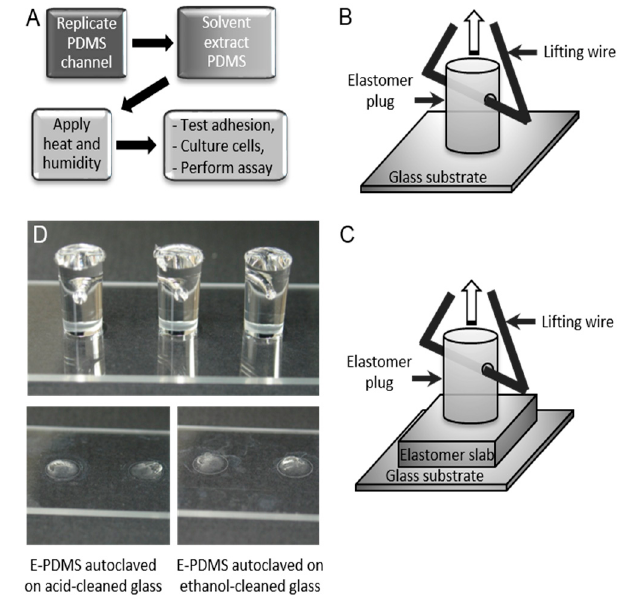
Figure 2. Overview of the annealing process and adhesion force measurements. ( A ) General overview of annealing process, from replicate molding of PDMS through cell culture. For microfluidics, masters are used to generate the PDMS microchannels. For plugs to measure adhesion forces, a 96-well plate serves as the replicate mold. Solvent extraction was performed with n-pentane, xylene, ethanol (200 proof), and DI water. ( B , C ) Schematic of PDMS plugs and substrate configurations. Holes punched through the plugs allow for wire supports to attach to the force scales. PDMS on glass ( B ) was used for annealing measures. PDMS on PDMS (“elastomer slab,” ( C )) was used to measure material deformations through profilometry. ( D ) Images of 3 plugs on a microscope slide for force measurements (upper image). E-PDMS plugs form strong adhesion bonds after solvent extraction and autoclaving. It is typical for E-PDMS annealed after extraction and autoclaving to tear, leaving elastomer fragments when being pulled off the glass, irrespective of glass cleaning method (lower